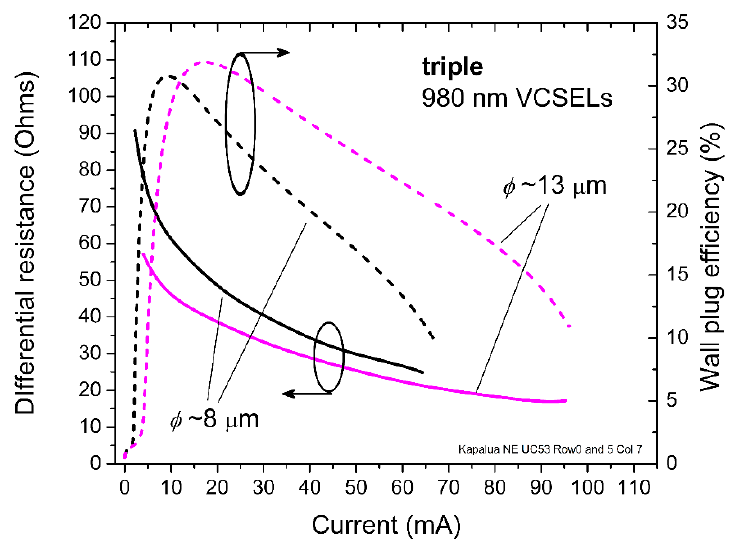
Figure 4. Extracted differential series resistance and wall plug efficiency versus DC bias current for the 980 nm triple VCSEL arrays in Figure 3 with ϕ ~8 and 13 μ m.